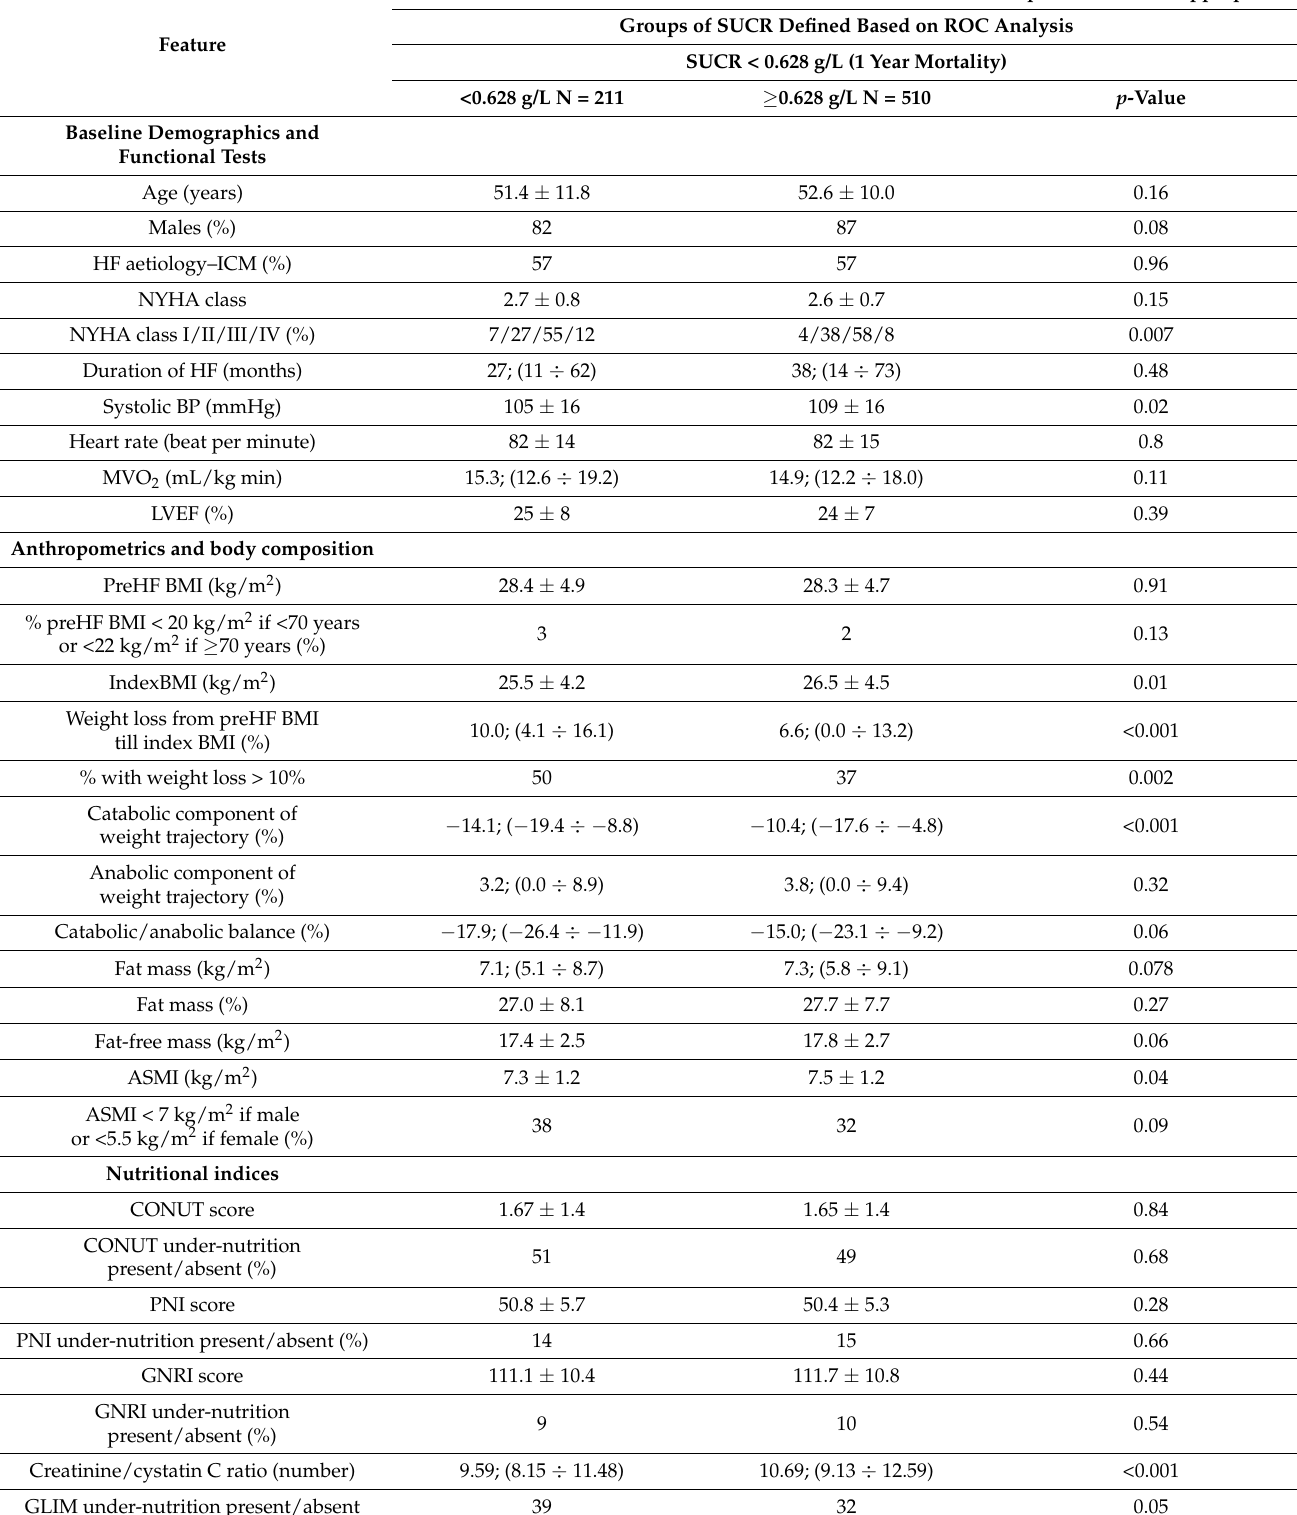
Table 2. Clinical characteristics and comparison of subgroups defined based on SUCR thresholds optimally discriminating death patients from alive at 1 year of follow-up (N =